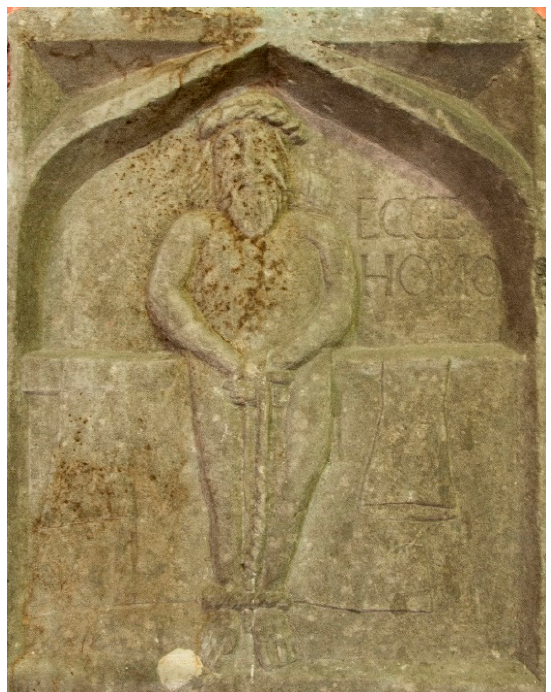
Figure 33. Ecce Homo , Carmelite Priory, Co. Kildare, sixteenth century. Photograph by the author.